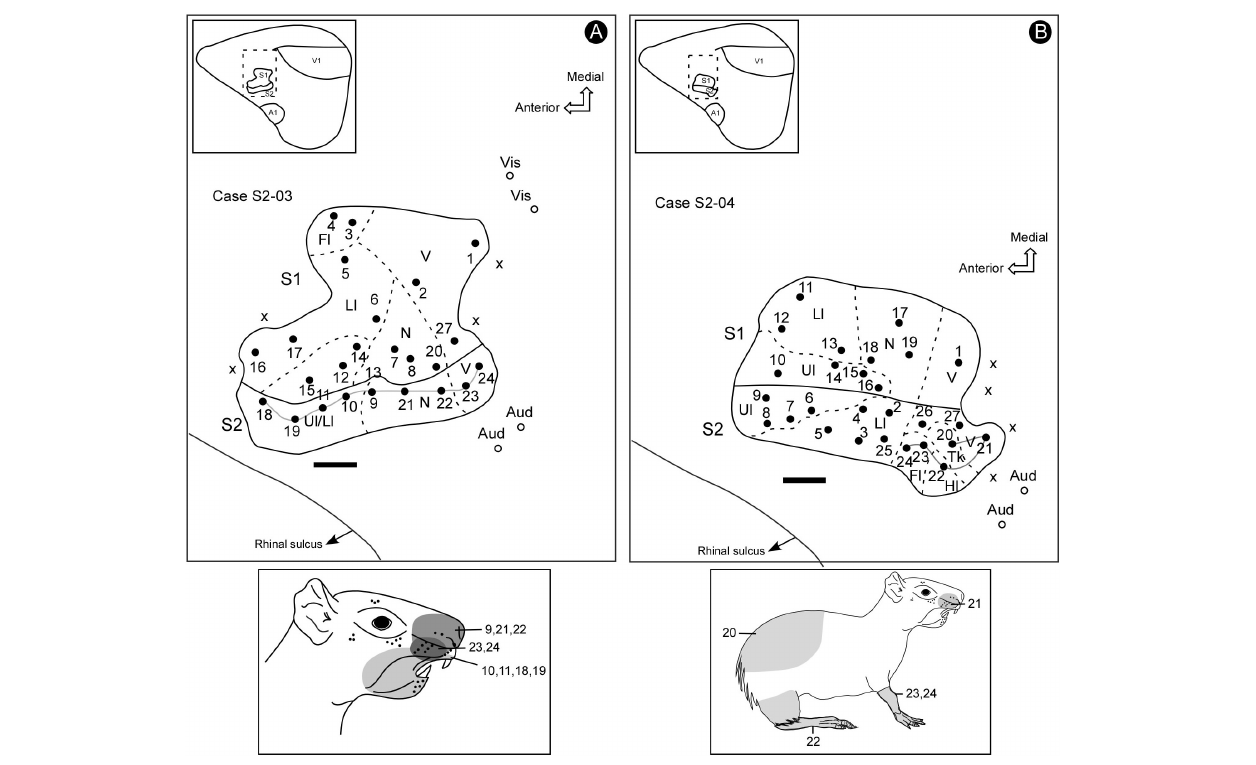
FIGURE 3 | Electrophysiological maps showing the organization of S2 and its relative location in the parietal cortex (inserts). S2 lies in a more lateral and posterior location in the parietal cortex, adjacent to the S1’s face representation, containing a complete representation of the contralateral sensory periphery, which is smaller and has a mirror-symmetrical orientation compared to S1 (A,B) . Receptive fields for associated electrode penetrations in cases S2-03 and S2-04 (continuous lines in maps in A,B ). The shaded areas in the schematic drawings indicate the receptive fields for corresponding electrode penetrations in the electrophysiological maps. Scale bars: 1 mm. Fl, forelimb; Hl, hindlimb; Ll, lower lip; N, nose; Tk, trunk; Ul, upper lip; V, vibrissae; X, no